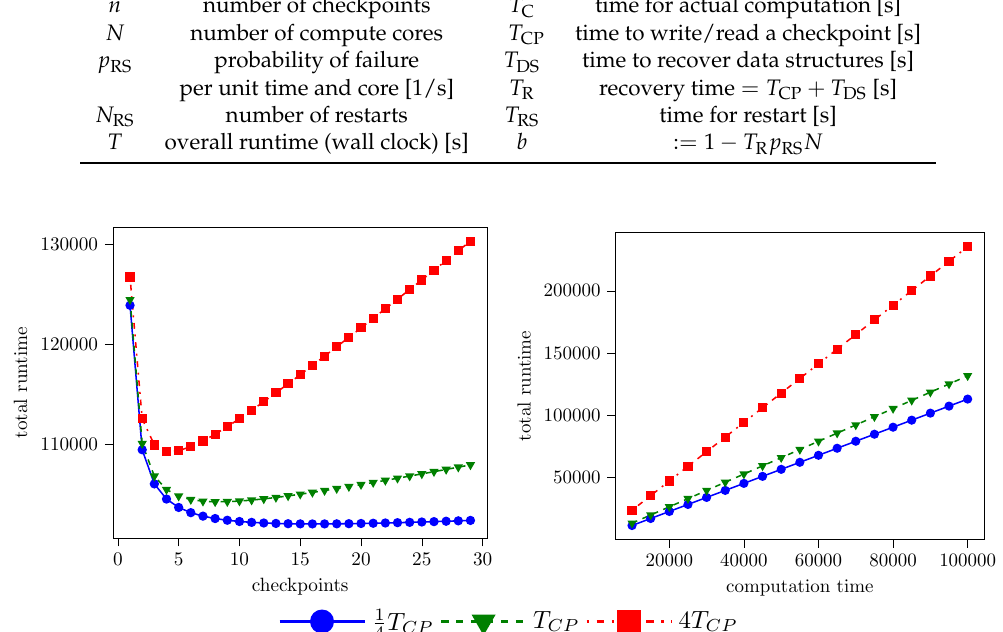
Figure 11. Influence of T CP , comparing the nominal scenario (green) to scenarios with T CP reduced (blue) and increased (red) by a factor 4. Left: overall runtime vs. number of checkpoints for N = 4 and T C = 100,000 s. Right: overall runtime vs. actual computation time for N = 100. In both cases p RS = 7.74 10 − 7 , T CP = 245.583 s and T R = 545.583 s were used. While the runtimes were measured × for the parallel-in-time solution of a 3D heat equation on the HLRN-III Cray XC30/XC40 supercomputer (www.hlrn.de), the probability of failure was determined from HLRN-III